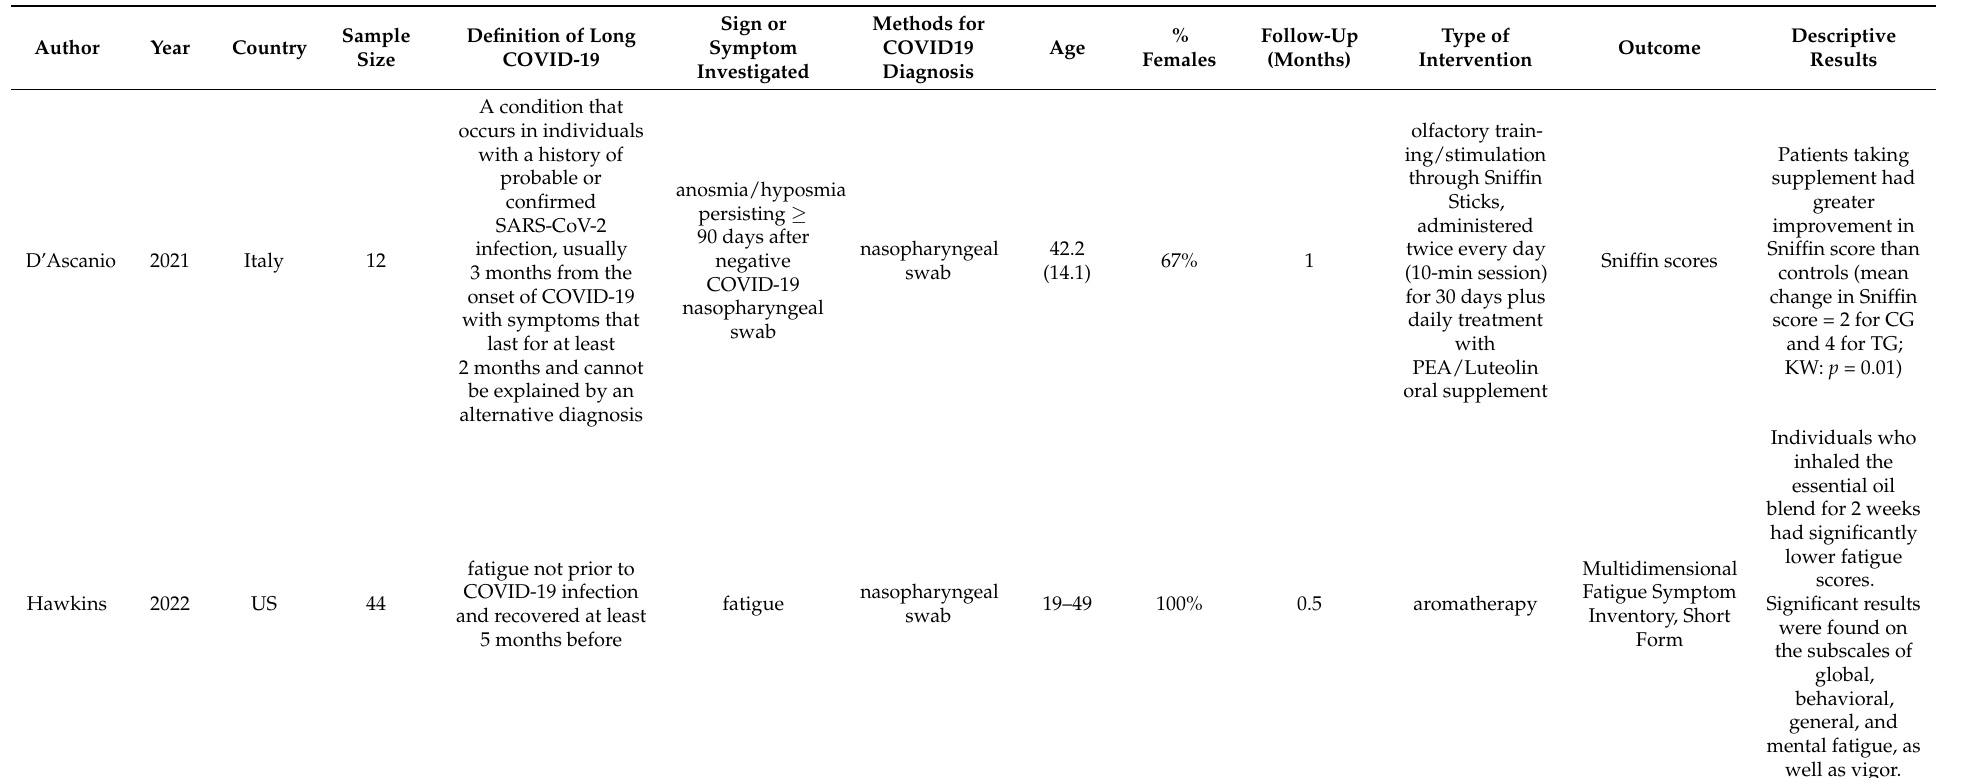
Table 1. Descriptive characteristics and main findings for the studies